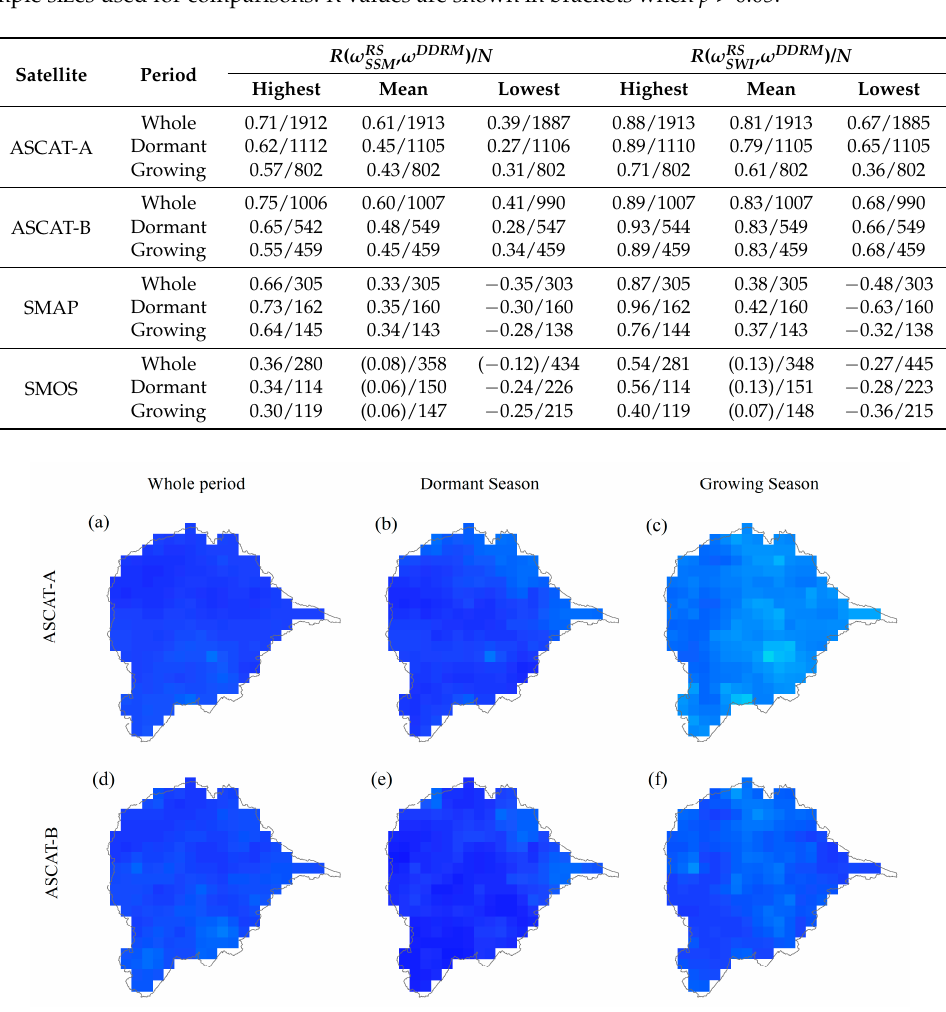
Table 5. Statistics of grid correlation-coefficient values between saturation degree values acquired from each remotely sensed product ( ω RS and ω RS ) with those from DDRM ( ω DDRM ) during different periods of 2010–2016 (the whole period, the dormant seasons and the growing seasons). N represents sample sizes used for comparisons. R values are shown in brackets when p > 0.05.